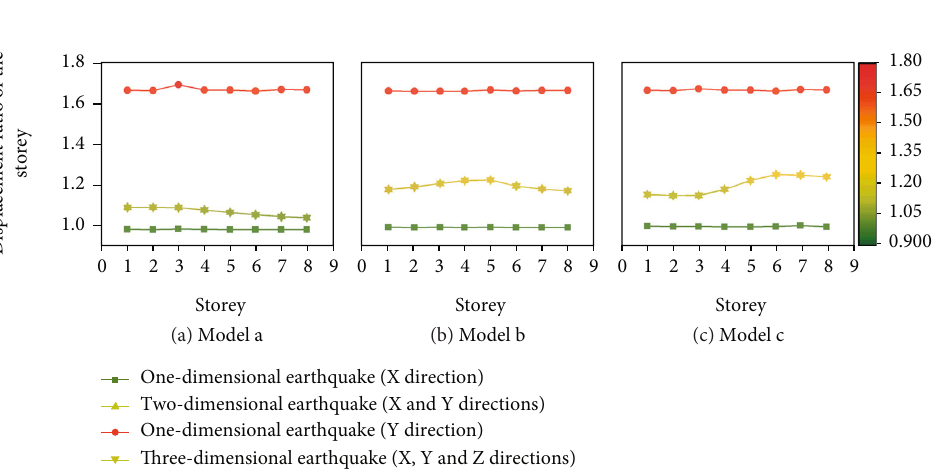
Figure 5: Floor displacement ratio in X -direction of di ff erent models under di ff erent dimensional earthquakes.